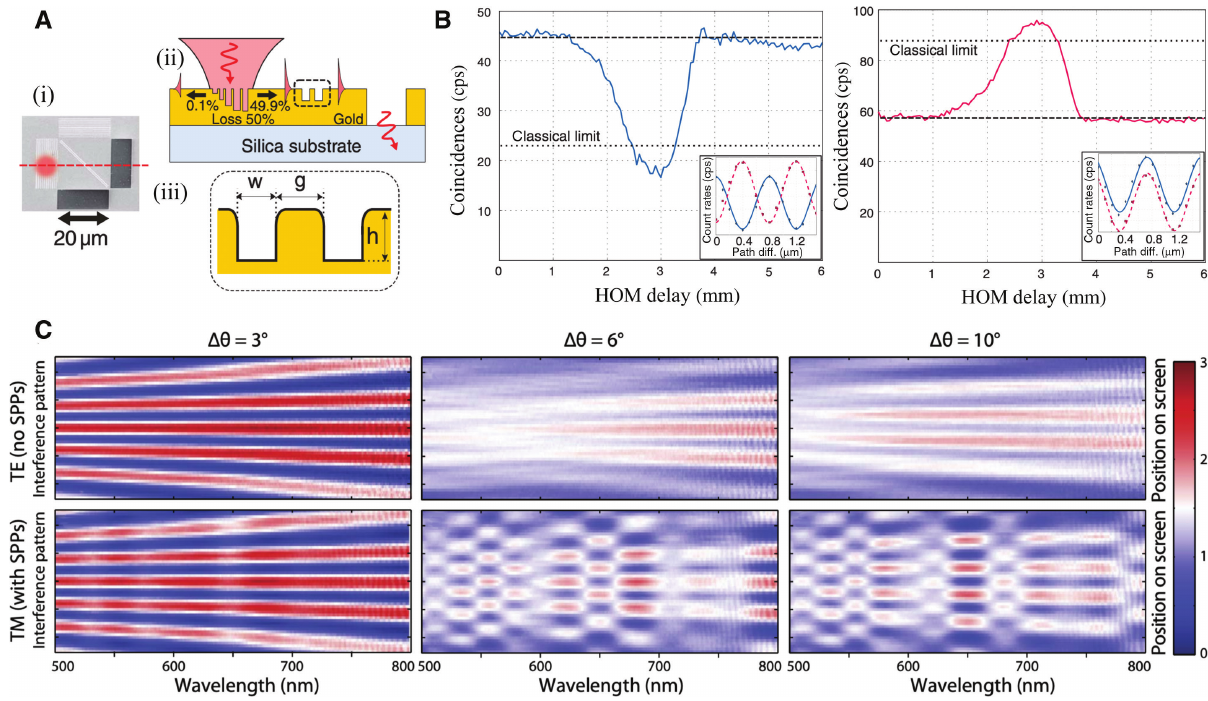
Figure 11: Control of quantum multiparticle interactions. (A) (i) SEM image of an integrated plasmonic beam splitter. (ii) Cross-section diagram of the integrated plasmonic beam splitter showing the photon-plasmon-photon process. The photons are converted to plasmon on the left, then launched into the plasmonic beam splitter (enclosed by black dashed line), and converted back into photons in the silica substrate. (iii, inset) Grating parameters that are used to control the transmission and reflection of photons in the plasmonic beam splitter. (B) Experimental observation of the plasmonic HOM coalescence/anticoalescence effects. (A and B) Reproduced from Ref. [127]. (C) Control of spatial coherence through surface plasmons in a metallic slit. Reproduced from Ref.